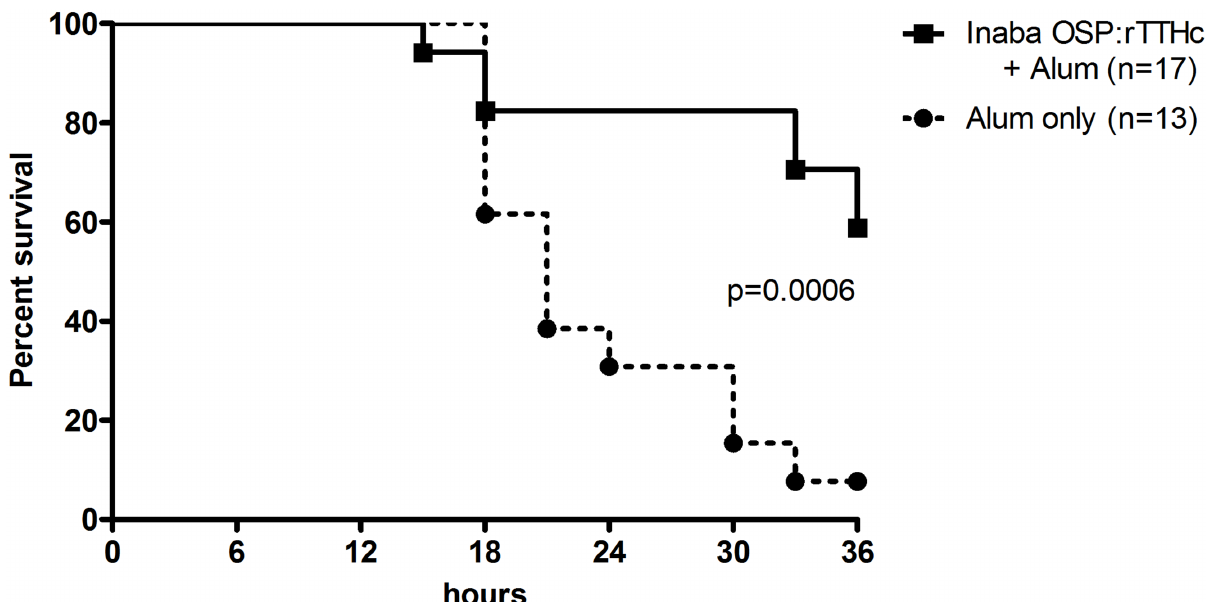
Fig 8. Survival likelihood of neonatal CD -1 mice following oral challenge with wild type V . cholerae O1 El Tor Inaba strain N16961. Three to five day old pups were orally gavaged with 50 μ l of a preparation containing 5.8x10 9 CFU of wild type V . cholerae N16961 mixed with a 1:250 dilution of pooled day 42 serum from mice intramuscularly immunized with conjugate vaccine (OSP:rTTHc) and immunoadjuvantative alum, or alum alone. Survival curves were compared by log rank testing.